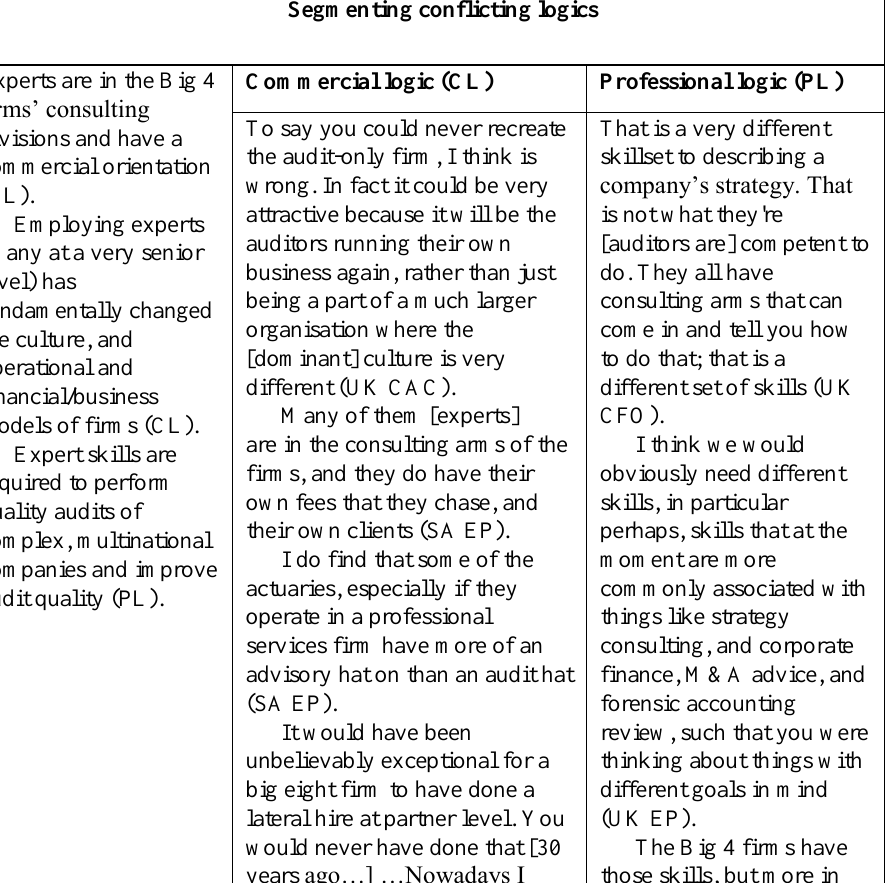
Table 3: Expert involvement: navigating logic multiplicity Segmenting conflicting